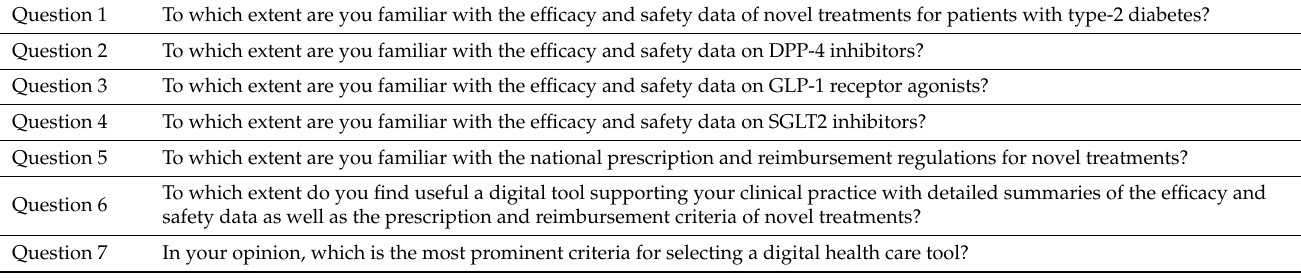
Table 1. The anonymous online survey